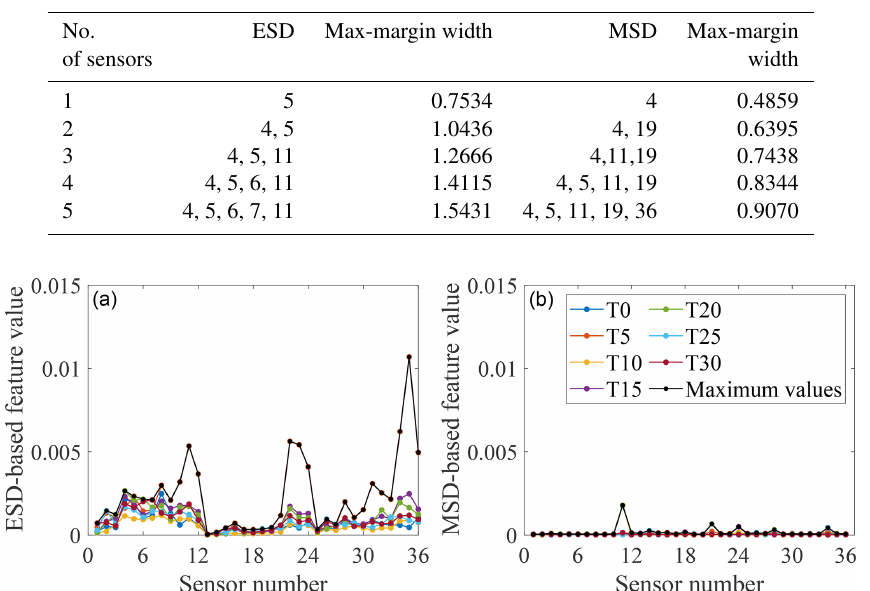
Table 3. Optimal sensor combination designed for the M1M2 case detection and corresponding max-margin widths.